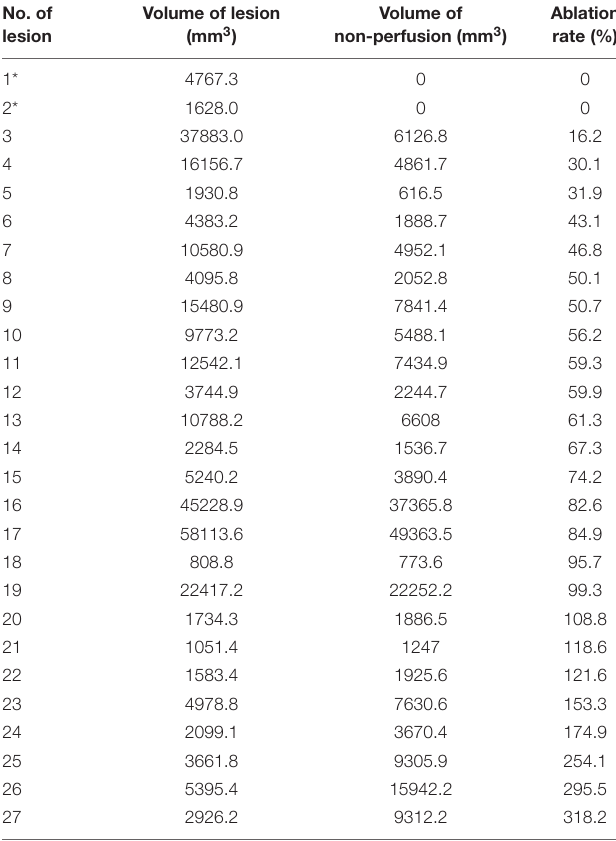
TABLE 6 | The ablation rate of the lesions on MRI.